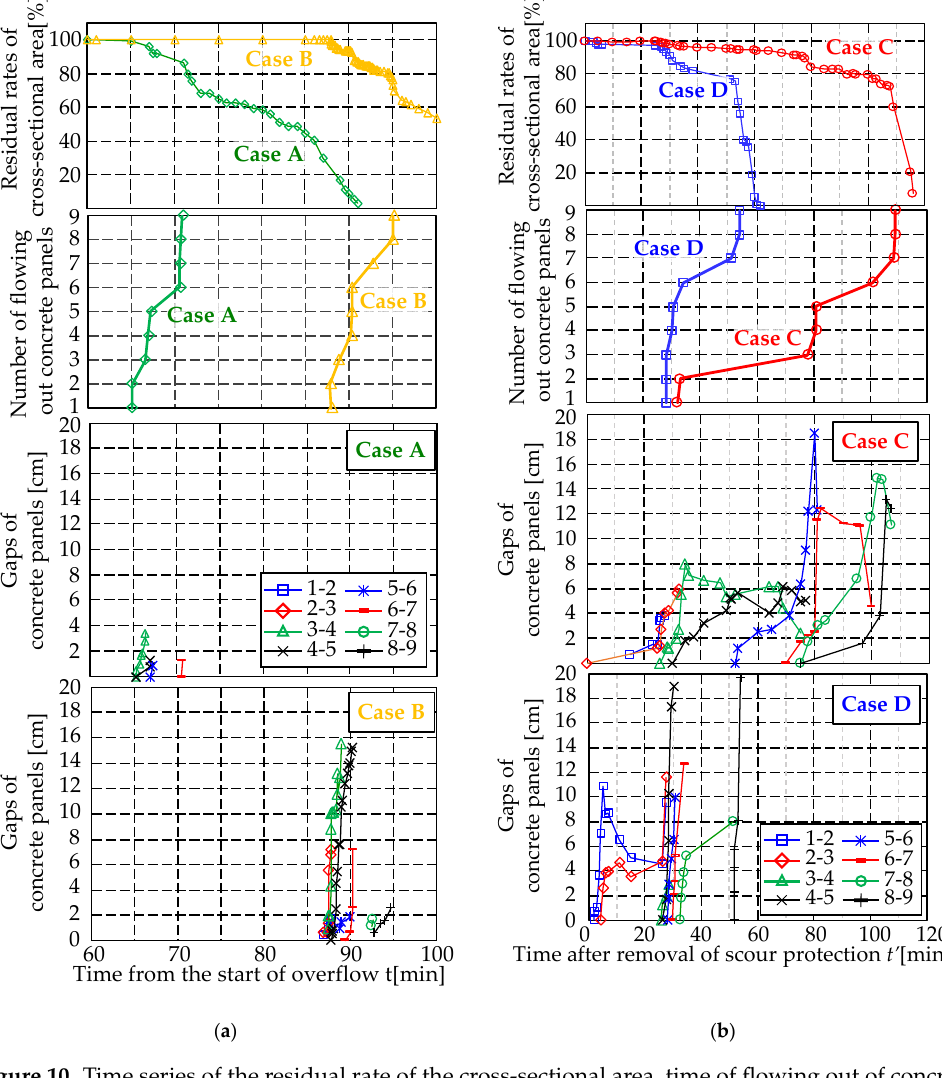
Figure 10. Time series of the residual rate of the cross-sectional area, time of flowing out of concrete panel at the back slope and the gaps between concrete panels: ( a ) Case A (armored levee) and Case B (GRS levee); ( b ) Cases C and D (LDR levee).